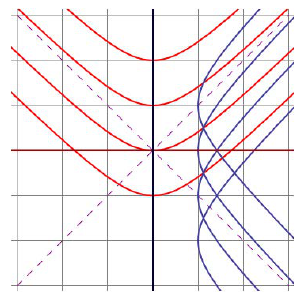
Fig. 3. Spacelike (blue) and timelike (red) pseudocircles in L 2 with constant positive curvature.